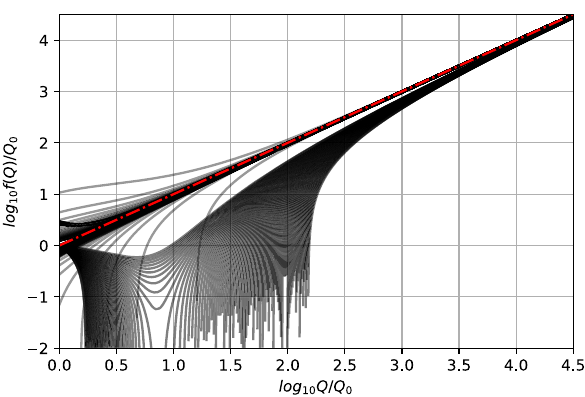
Fig. 3 Plot of log 10 f ( Q )/ Q 0 over log 10 Q / Q 0 for models 1 to 5. Red dashed-dotted line corresponds to GR limit